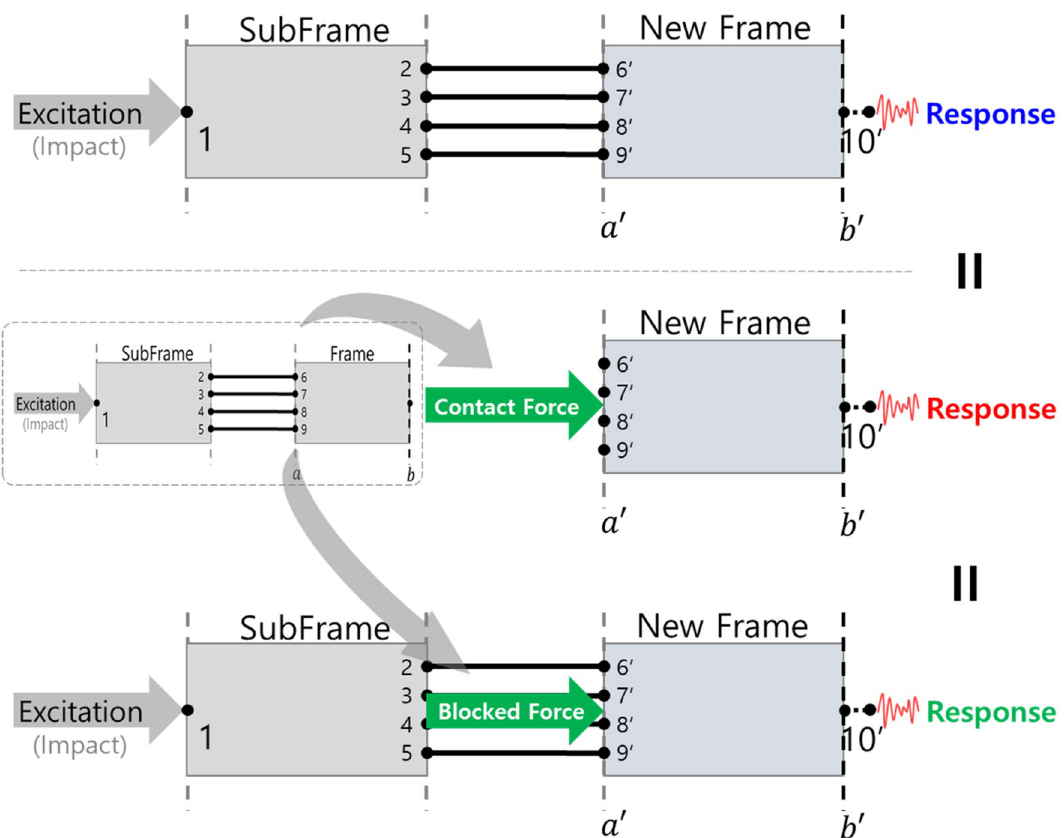
Figure 11. Schematic diagram of the response to the application of a new